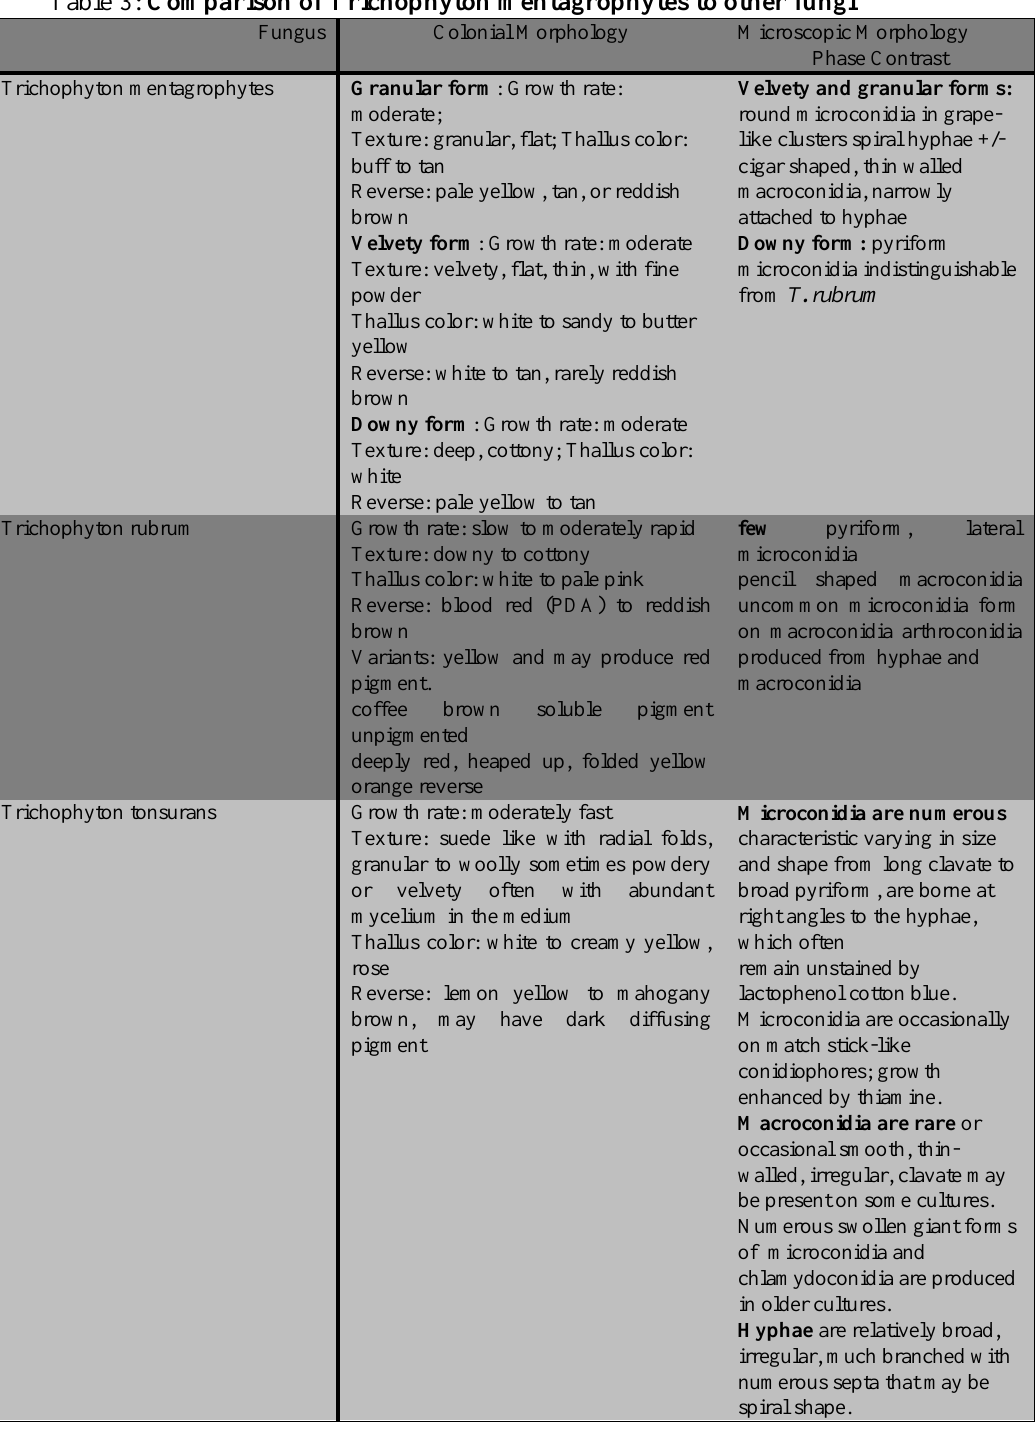
Table 3: Comparison of Trichophyton mentagrophytes to other fungi (35)